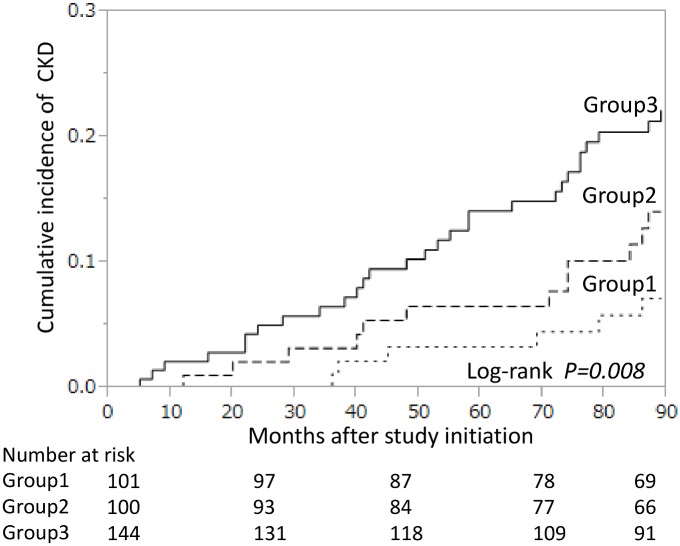
Cumulative incidence of CKD for each C-reactive protein (CRP) subgroup.Observation was started from the third measurement of CRP. Short-dashed line, group 1 (no elevation of CRP values defined as all three CRP values ≤3.0 mg/L); long-dashed line, group 2 (transient high CRP values defined as one or two CRP values >3.0 mg/L); solid line, group 3 (persistently high CRP values defined as all three CRP values >3.0 mg/L). The differences between groups were compared using a log-rank test.